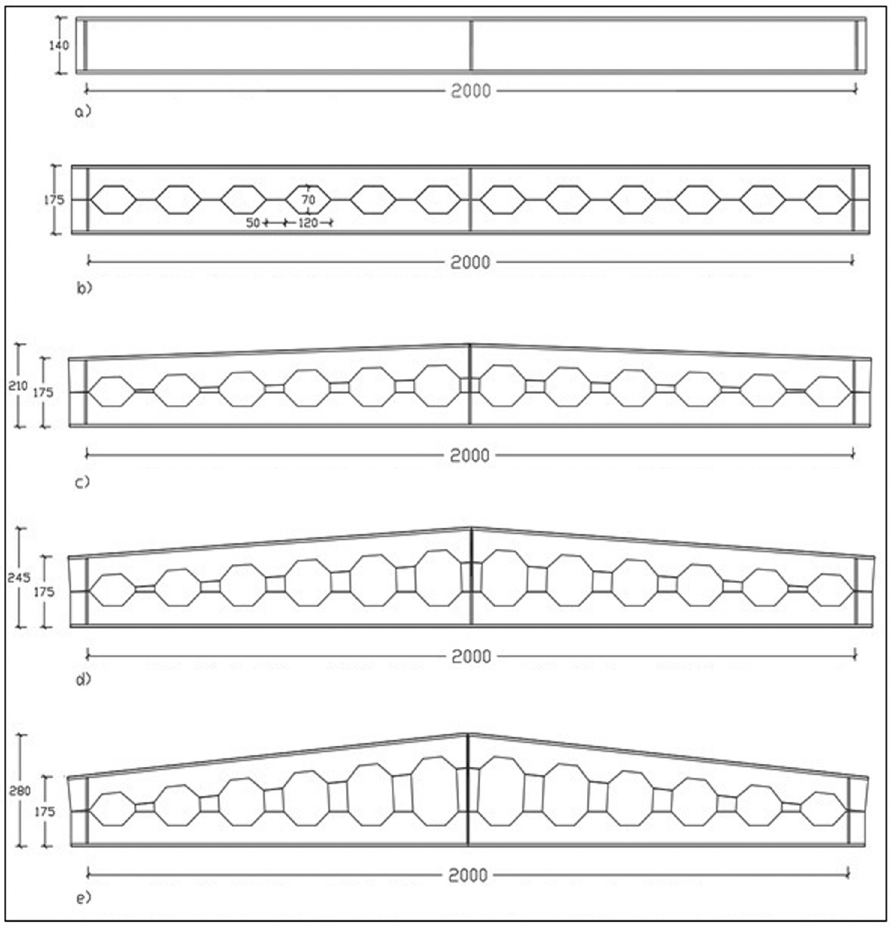
Figure 4: Dimensions and notations of all tested specimens. ( a ) Parent beam: specimen ( Control ) , ( b ) castellated beam without expansion plate: specimen ( CBN - 0 ) [ H h 1.0 / = ] , ( c ) tapered castellated beam with variable expansion plate: specimen ( CBN - 1 ) [ H h 1.2 / = ] , ( d ) tapered castellated beam with variable expansion plate: specimen ( CBN - 2 ) [ H h 1.4 / = ] , ( e ) tapered castellated beam with variable expansion plate: specimen ( CBN - 3 ) [ H h 1.6 / = ]